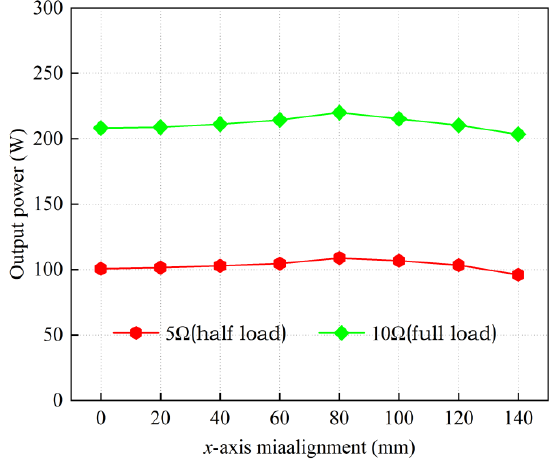
Electronics 2023 , 12 , x FOR PEER REVIEW Figure 14. The output power under different load and misalignment conditions. Figure 14. The output power under different load and misalignment conditions.